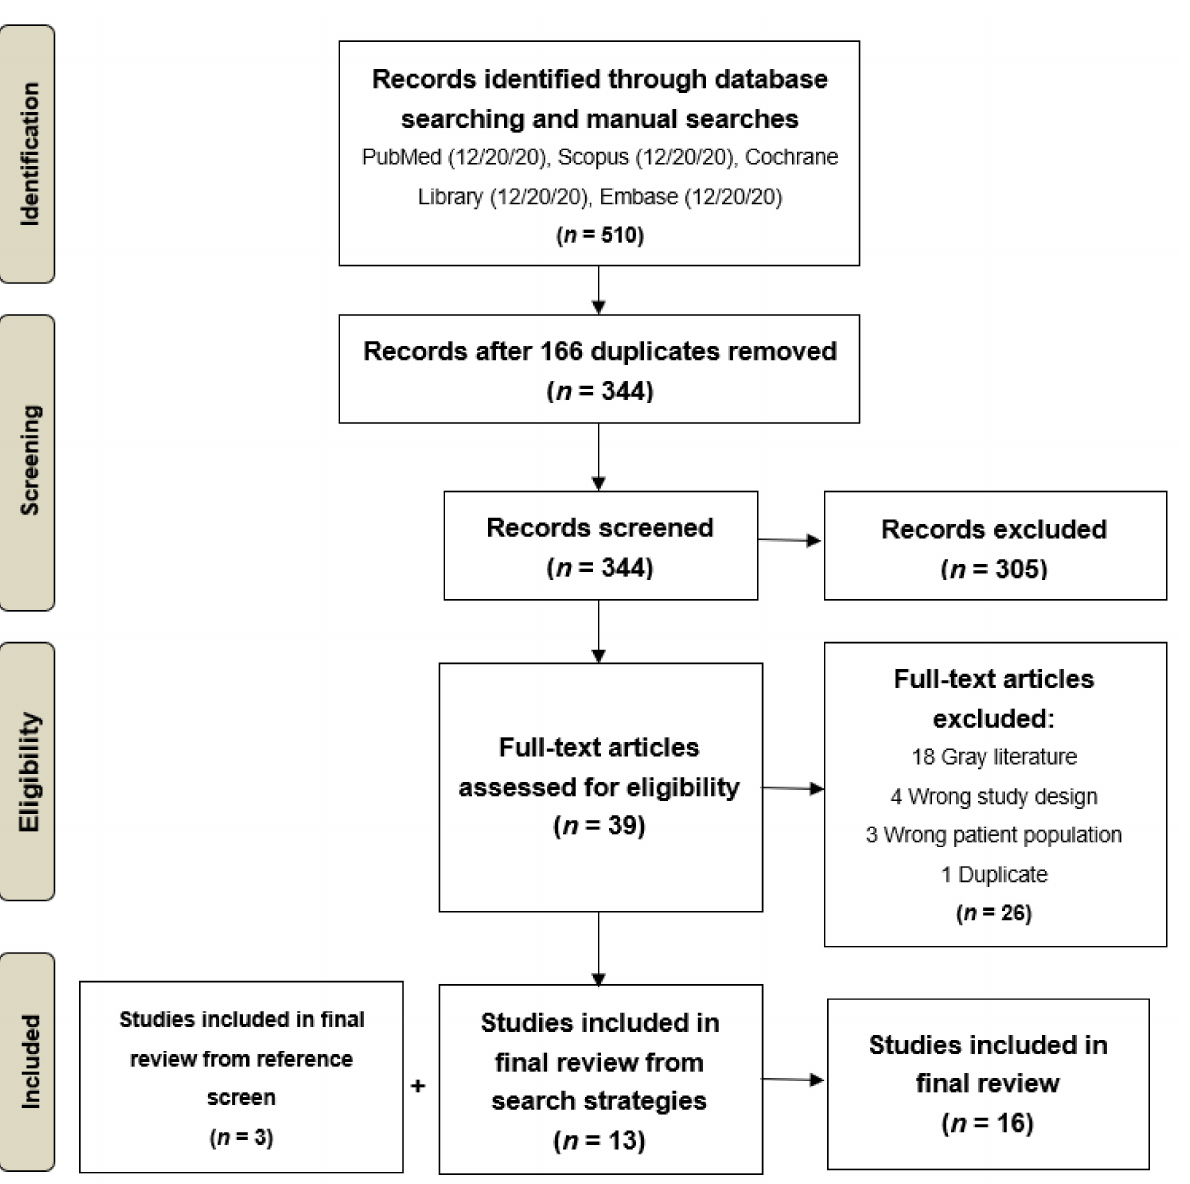
Figure 2. Flow diagram of the systematic review